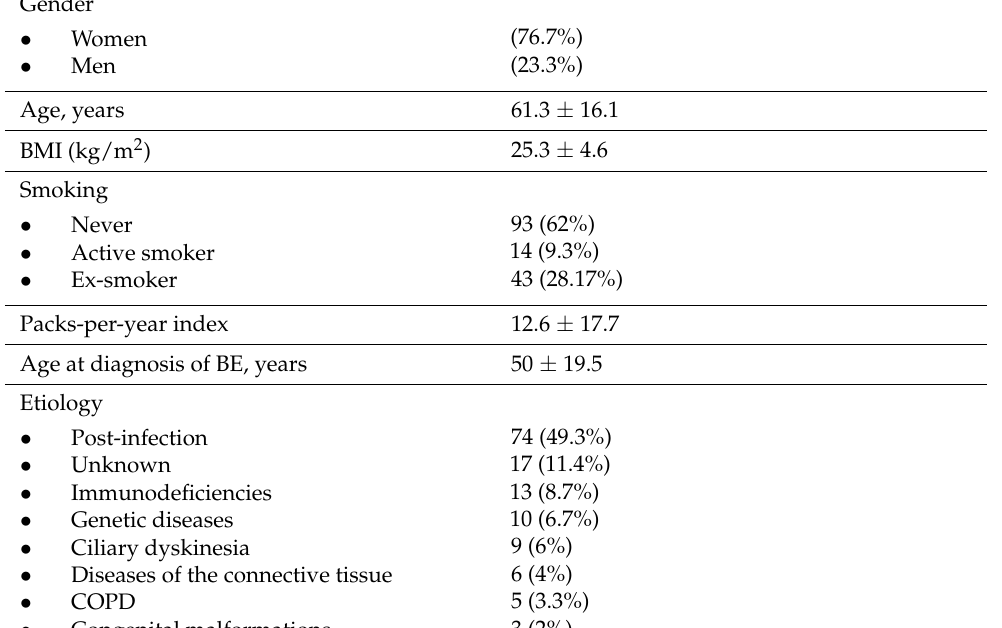
Table 1. Baseline characteristics of the